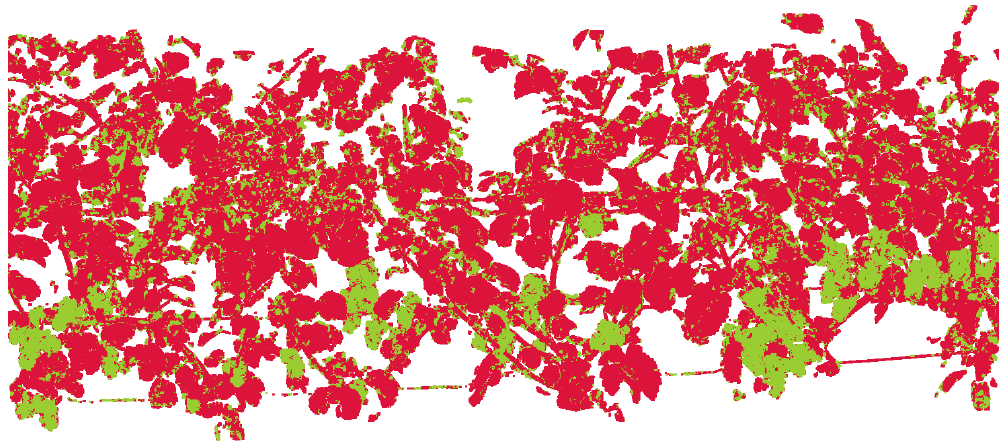
Figure 9. Initially classified point cloud. Red points belong to the canopy and green points to the grape bunch class. False classifications are recognizable, especially where objects lie close